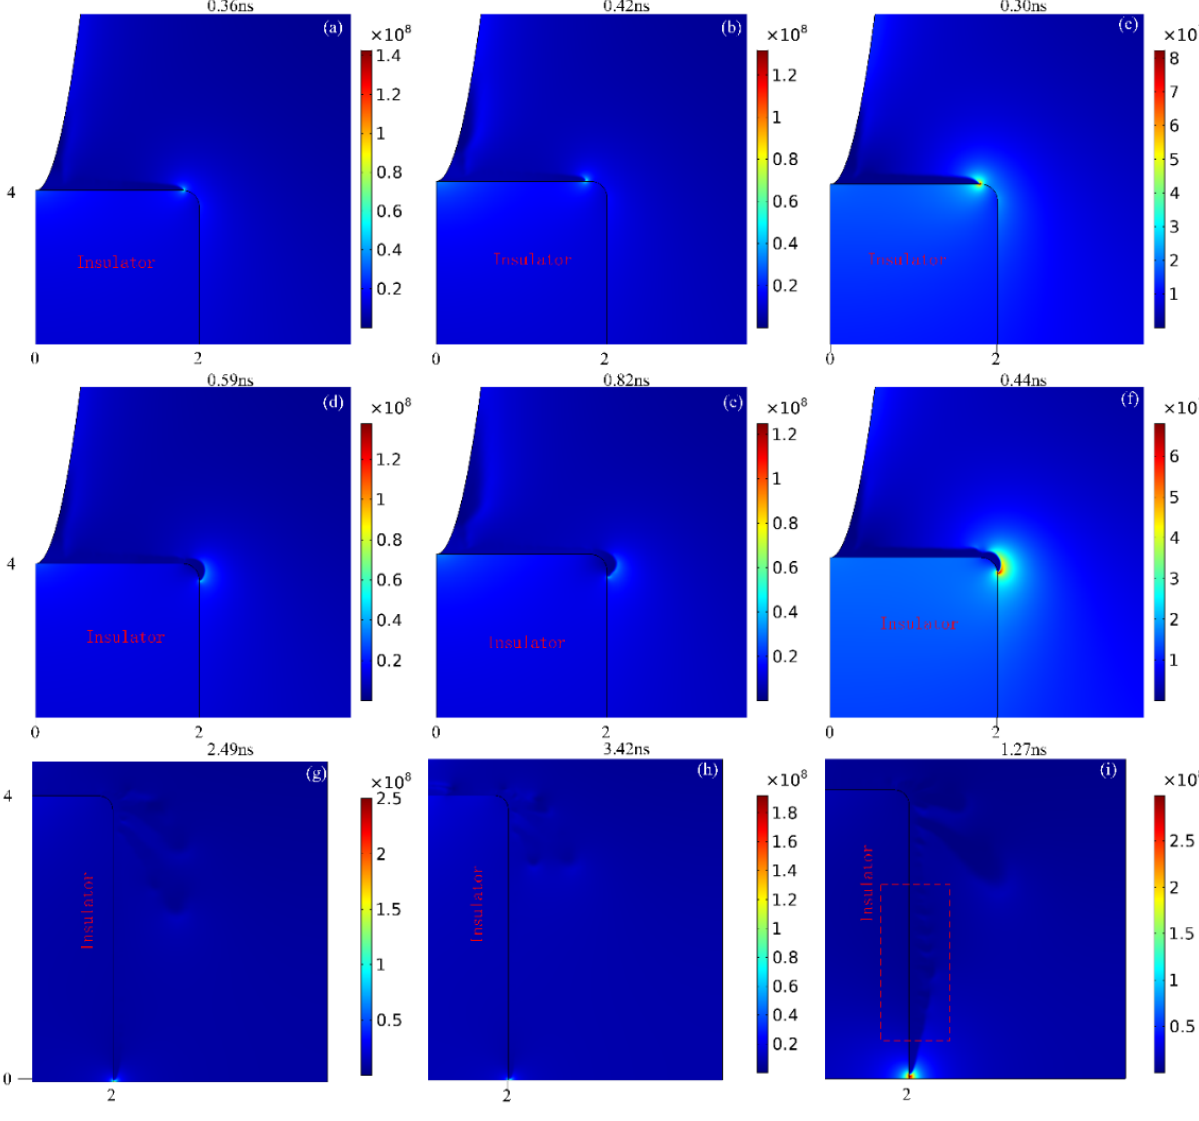
Figure 9. Electric field (V/m) distribution in three models: ( a – c ) streamer head at the end of the upper surface of the insulator in model A, B and C; ( d – f ) streamer head at the top of the right surface of the insular in model A, B and C; ( g – i ) streamer head at the bottom of the right surface of the insular in model A, B and C; the scale unit is millimeters (mm).